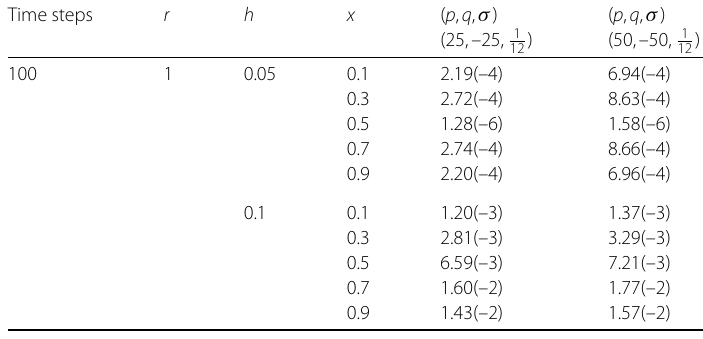
Table 4 L ∞ error for Example